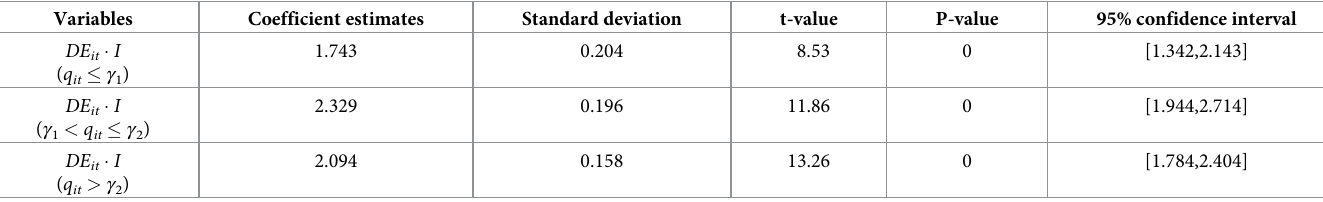
Table 7. Regression results of the threshold panel